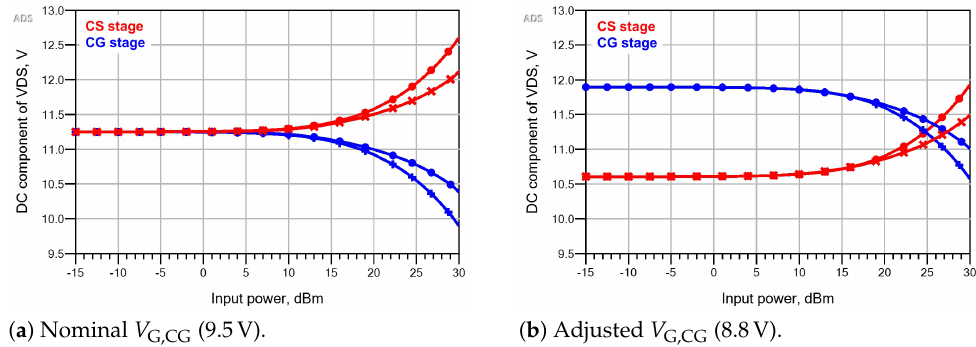
Figure 14. DC drain-source voltages of the CS (red) and CG (blue) stage as a function of input power for both L SHUNT -based (circles) and L GS -based (crosses)